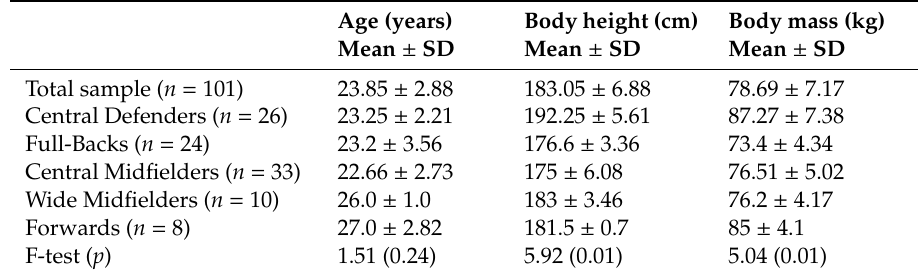
Table 1. Sociodemographic and anthropometric characteristics of the studied players with di ff erences among playing positions